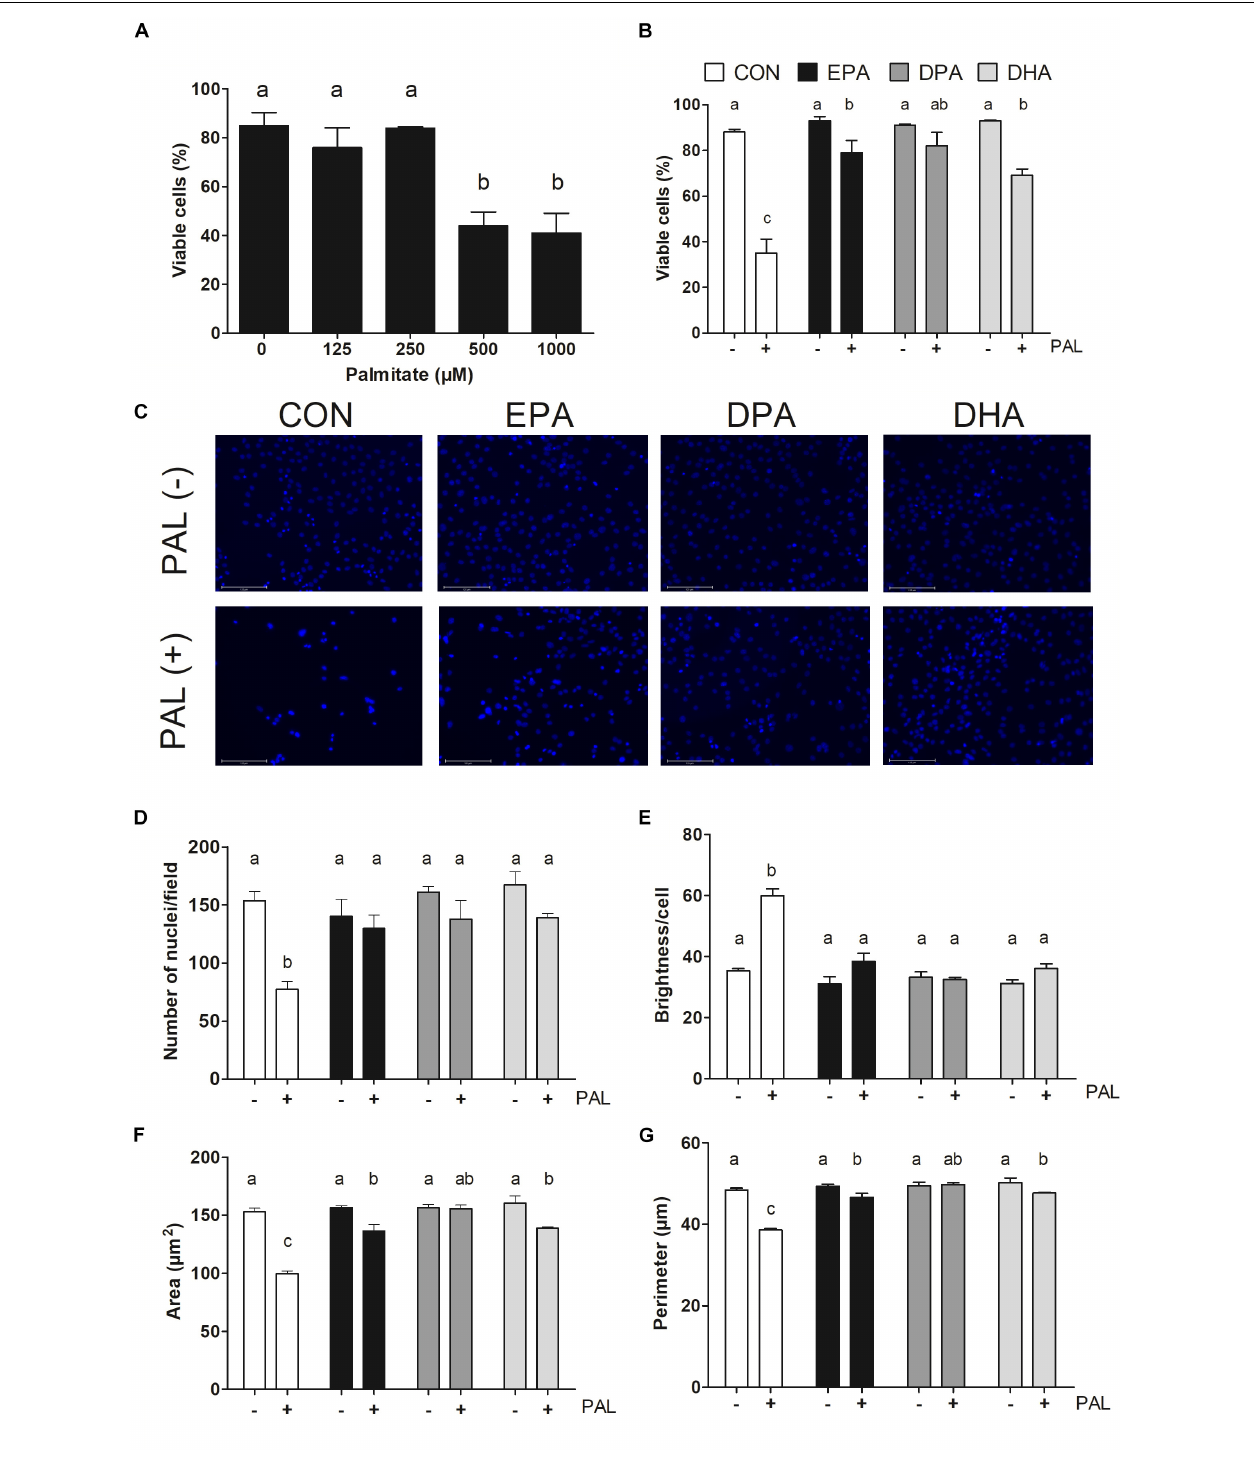
FIGURE 1 | EPA, DPA, and DHA protect against PAL-induced reductions in cell viability. Trypan blue exclusion test dose response experiment in myoblasts following 16 h of palmitate (PAL) treatment to assess cell viability (A) . Trypan blue exclusion test of cell viability following treatment with 500 µ M PAL and/or 50 µ M EPA, DPA, or DHA (B) . Representative images of nuclear DAPI staining following treatments (C) . Average number of nuclei/field (D) , brightness/nuclei (E) , nuclear area (F) , and nuclear perimeter ( µ m) (G) . Treatments that do not share letters are considered statistically significant ( p < 0.05; myoblasts were cultured and harvested independently to generate a total sample size of 3–4 biological replicates). Scale bar represents 125 µ m. Values are presented as mean ± SEM.